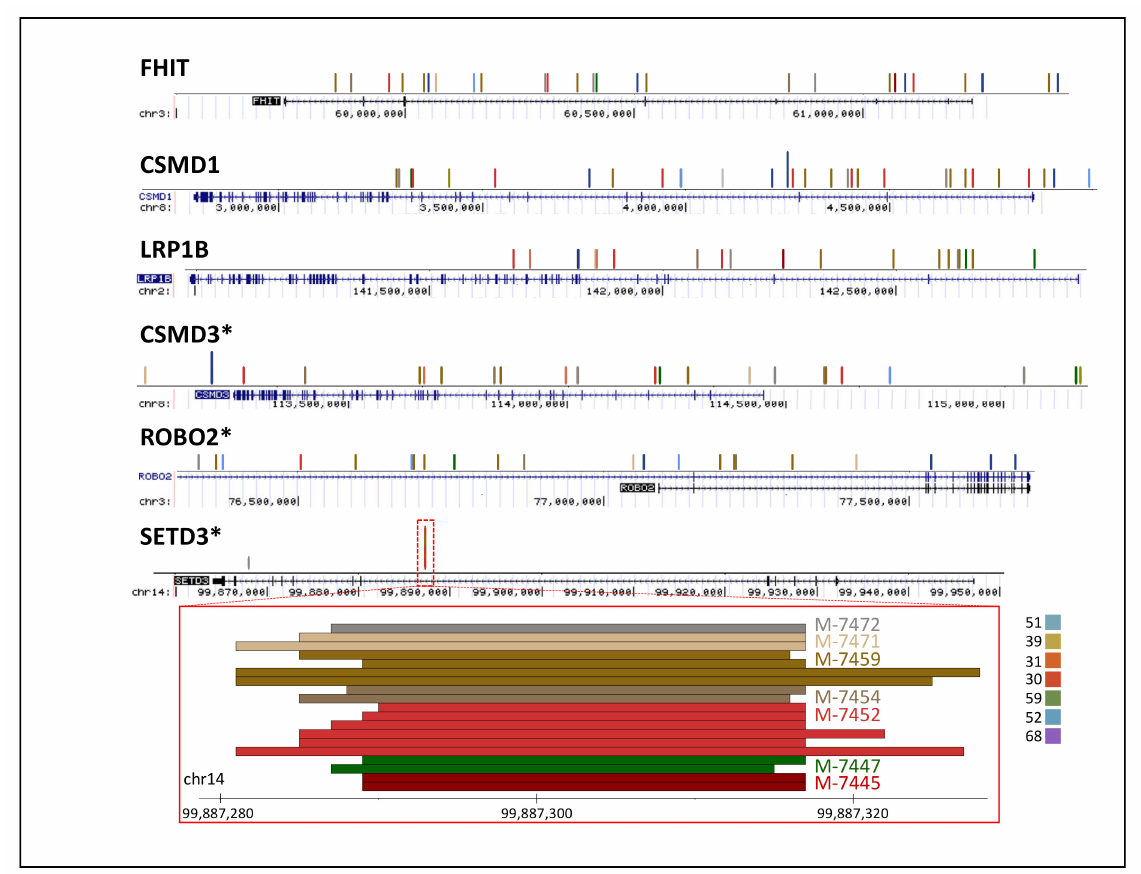
Figure 6. Examples of multiple integrations in known and novel genes. In each gene, a colored vertical segment represents a read. Different segment colors represent different samples. A specific region in the SETD3 gene is detailed. Samples and corresponding integrations for HPV types are Scheme